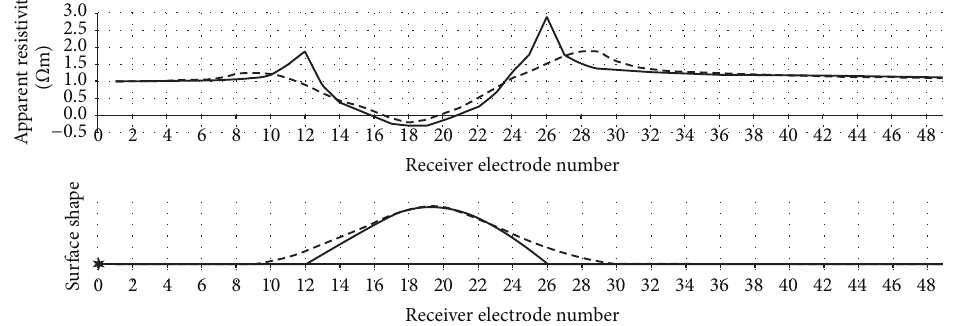
Figure 3: The shape of the surface relief and curves of 𝜌 𝑎 for a three-electrode array on a hemispherical crown. A star indicates the position of the current source electrode. — indicates surface with sharp angles; ---- indicates surface with smooth corners.